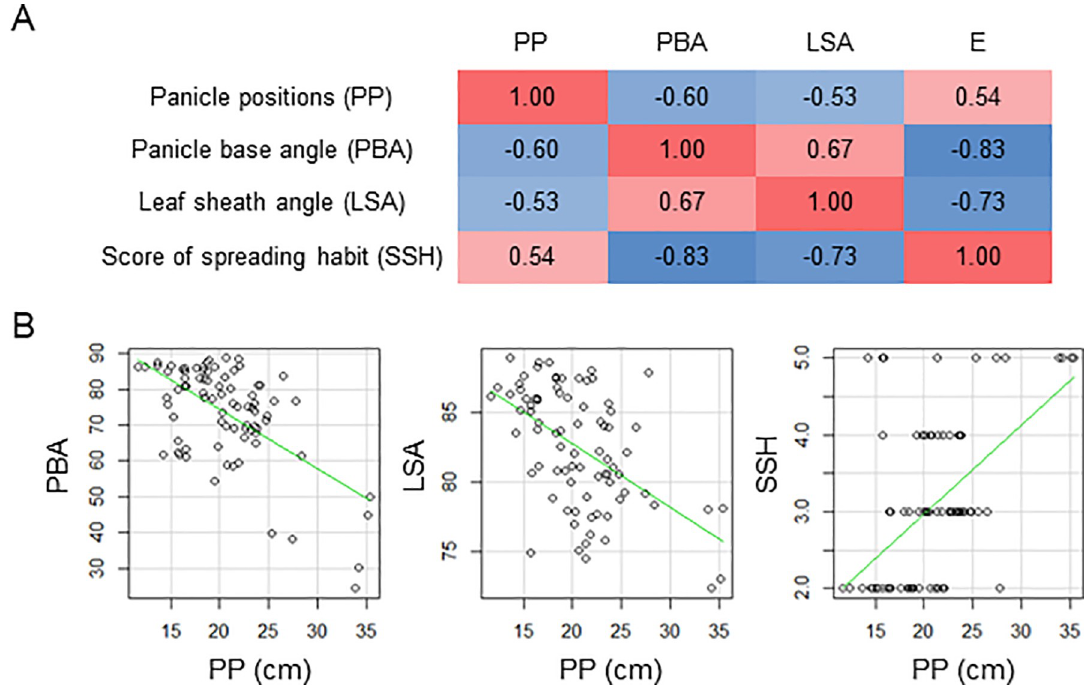
Fig 5. Relationships between PP and related data. (A) Pearson correlation coefficients. All correlations were significant ( P < 0.001). (B) Scatter plots of PP against PBA, LSA, and SSH. Fitted lines are green.